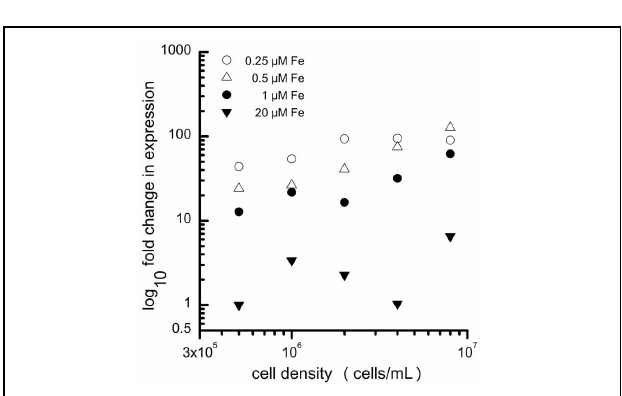
FIGURE 3 | Expression of FOX1 depends both on extracellular iron content (0.25 µ M, open circles; 0.5 µ M, filled triangles; 1 µ M, filled circles; 20 µ M, filled inverted triangles) and the number of cells per mL. The increased expression of FOX1 during growth of the batch culture likely reflects the reduced Fe availability on a per cell basis. Adapted from Urzica et al.